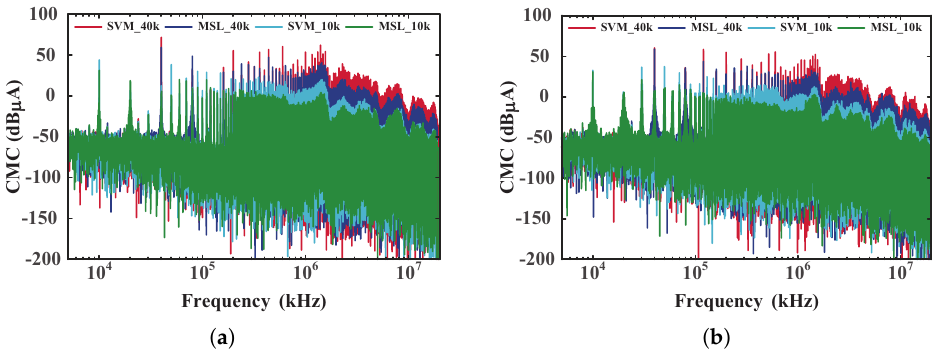
Figure 16. FFT analysis ( a ) at f o = 25 Hz with half load and ( b ) at f o = 50 Hz with full